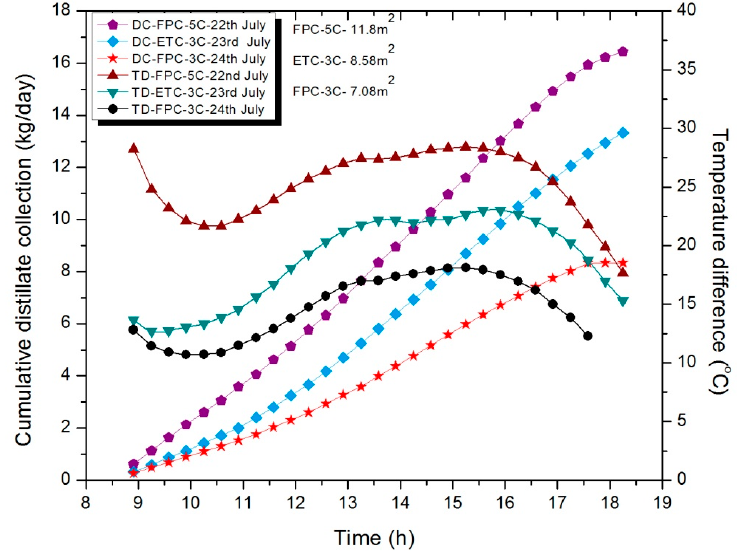
Figure 11. Cumulative daily distillate profile and MD driving force with different collector area.